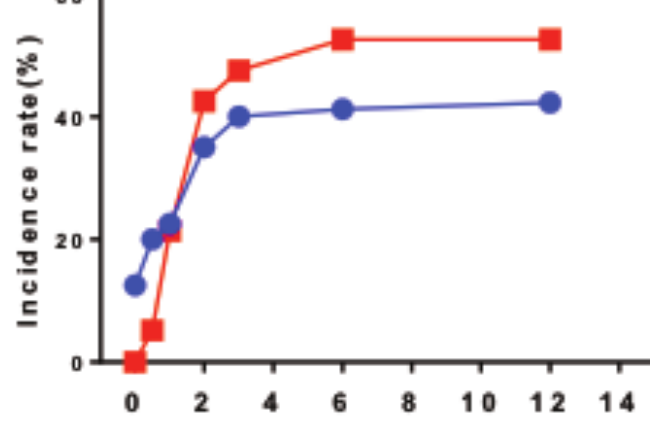
Figure 1: The incidence rate of spasticity and pain in the upper